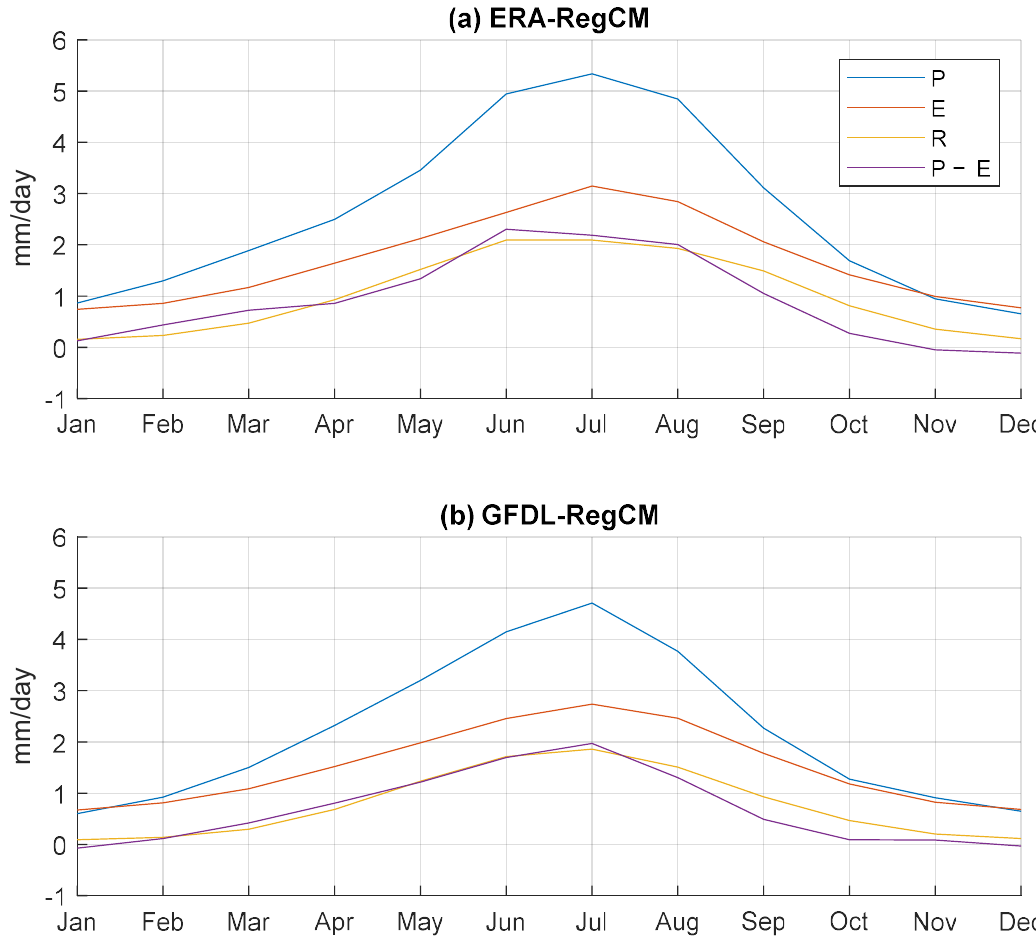
Figure 5. Simulated annual cycles for precipitation, evapotranspiration, runoff, and the difference between precipitation and evapotranspiration in the baseline period.